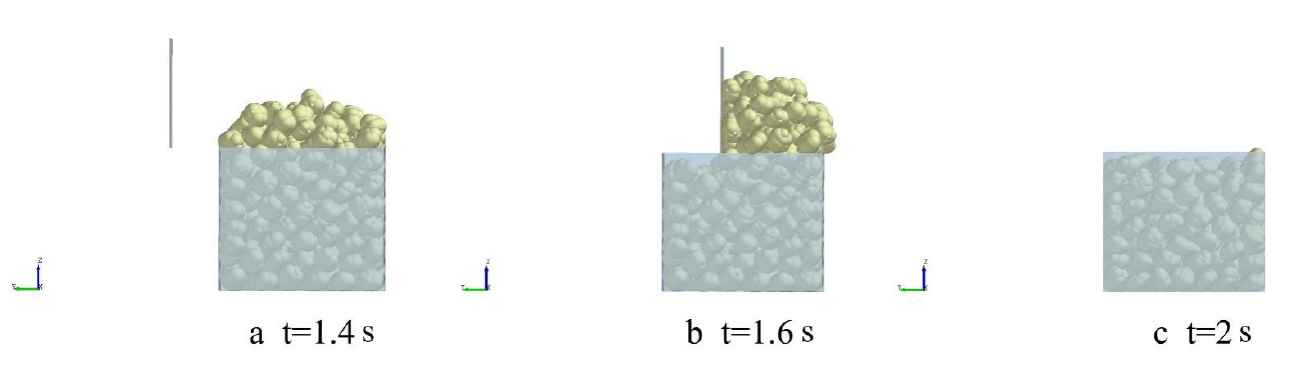
Figure 23. Snapshots of the simulation of the bulk density test of Jinong 3 seeds at different times using the 9-sphere model: ( a ) t = 1.4 s; ( b ) t = 1.6 s; ( c ) t = 2 s.